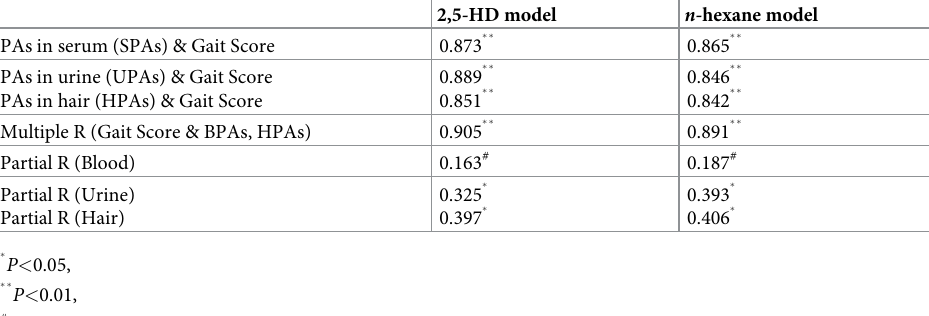
Table 5. Multiply regression analysis and partial